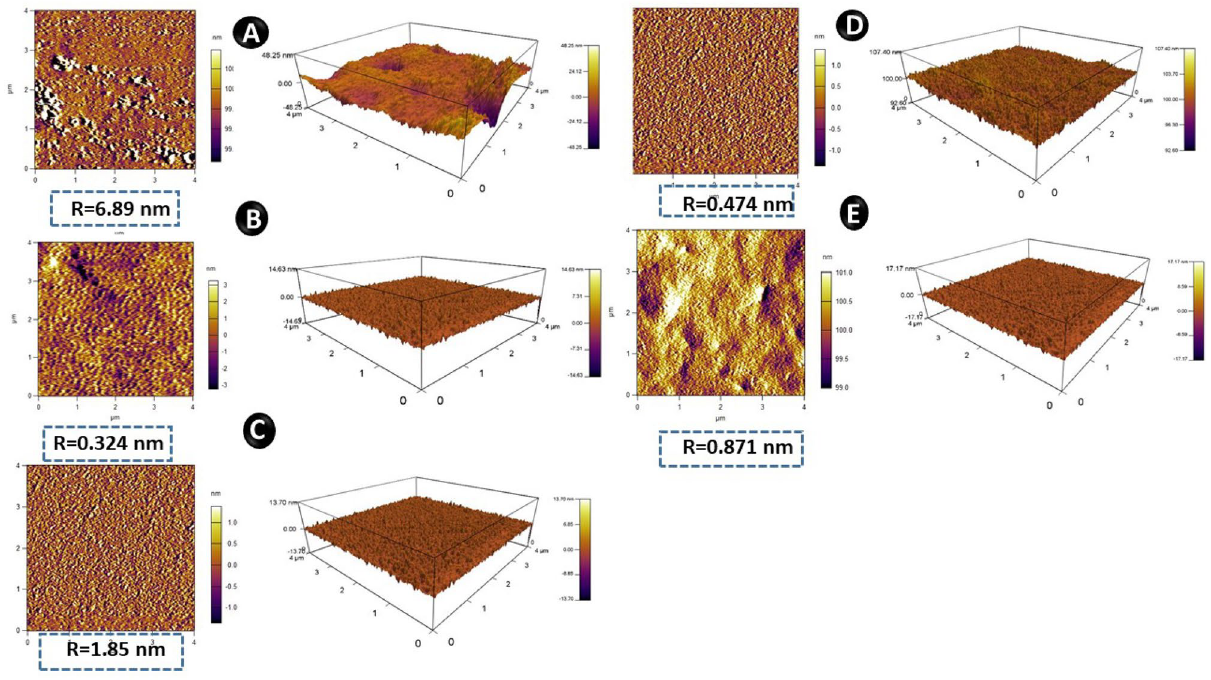
Figure 7. AFM analysis of ( A ) p MMA; ( B ) p MS1; ( C ) p MS2; ( D ) p MD1 and ( E ) p